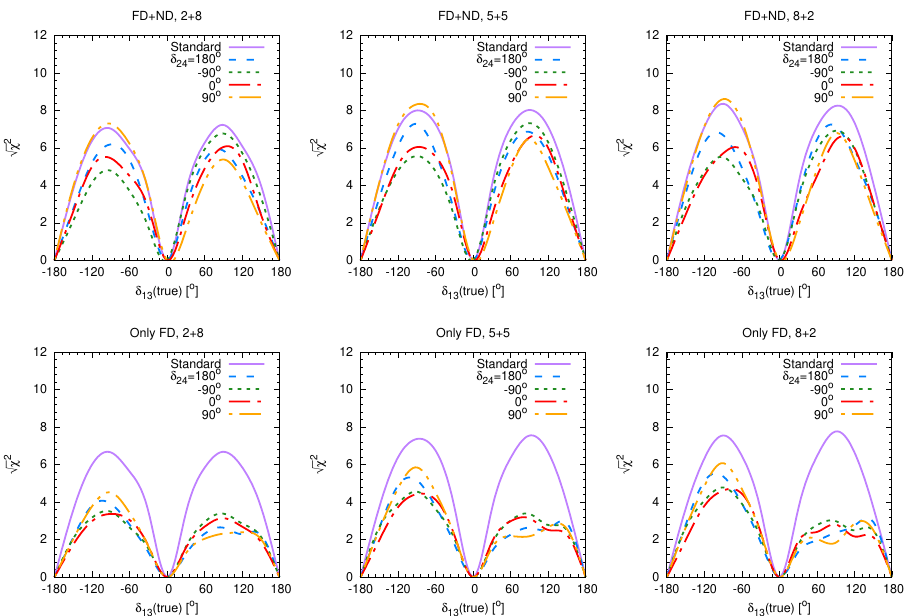
Figure 5 . CP violation sensitivity of ESSnuSB for four di(cid:11)erent values of true (cid:14) true (cid:14) 13